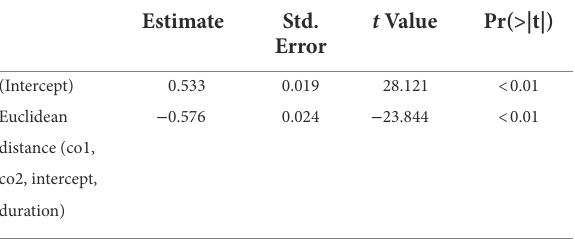
TABLE 1 Summary of the best-fitting model for the goodness ratings of the prototype and its referent set.